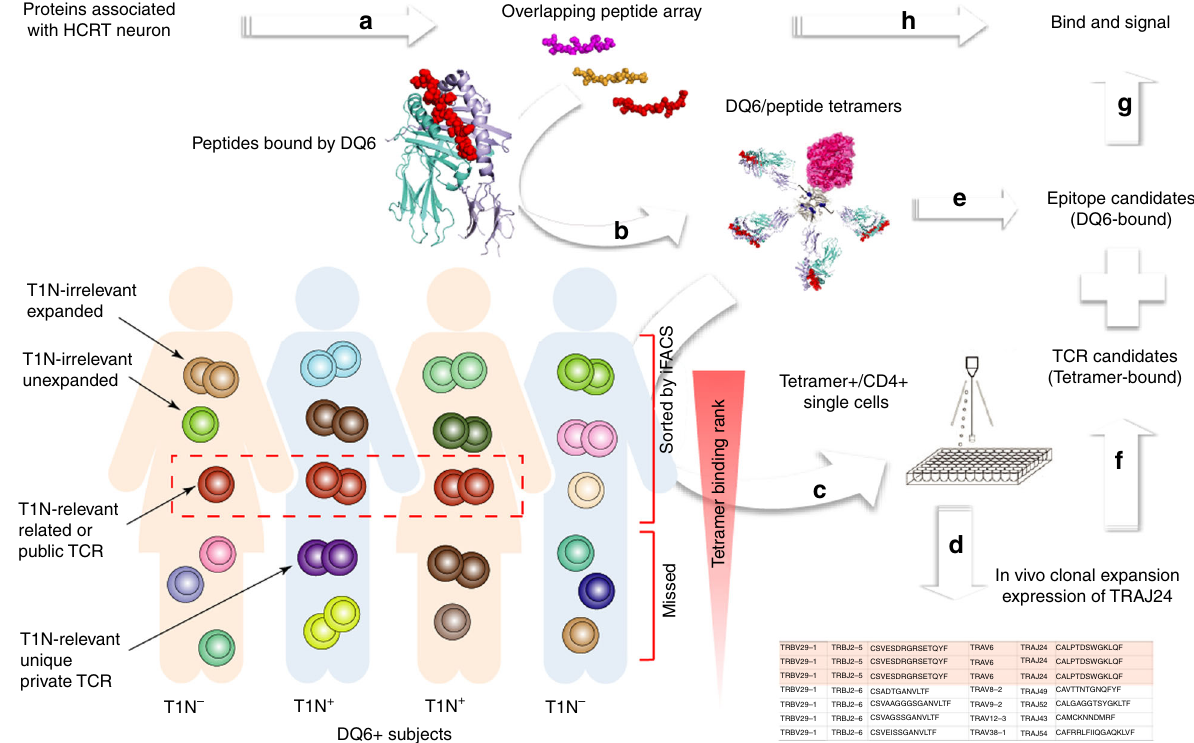
Fig. 1 Schematic illustration of approach. a An array of overlapping peptides covering the entire candidate autoantigen HCRT is tested for HLA-DQ6 binding. b DQ6-HCRT peptide tetramers are synthesized based on the DQ6-binding cores determined in a . c Ex vivo CD4 + T cells are isolated from PBMCs of DQ6 + patients and controls using negative selection by magnetic-activated cell sorting (MACS); puri fi ed CD4 + T cells are co-stained with candidate tetramers and antibodies distinguishing cell types (i.e., anti-CD4, anti-CD19). DQ6-HCRT peptide tetramer + /CD4 + cells are sorted by single cell index sorting (iFACS). Given the discordance between tetramer positivity and true autoreactivity, the iFACS-sorted cells likely include tetramer + clones with various tetramer-binding ranks, clone size, and disease-relevance: T1N-relevant (darker clones expressing public/related TCRs or unique/private TCRs) or irrelevant (lighter clones); expansion is indicated using doublets. Clones expressing TCR risk gene alleles may also be observed in DQ6 + controls, as